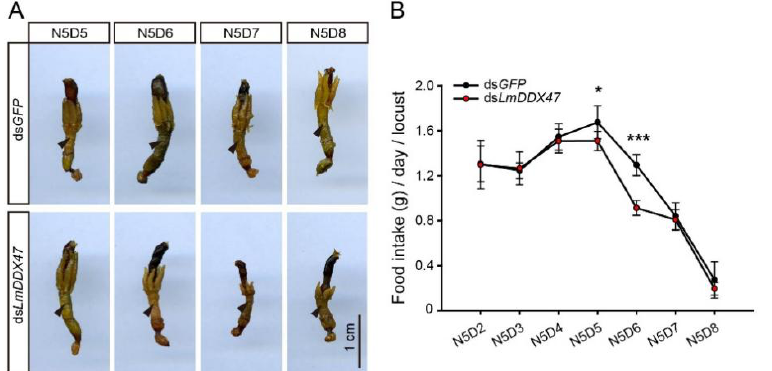
Figure 4. Dynamic changes in intestinal morphology and food intake after LmDDX47 knockdown. ( A ) Dynamic changes in the intestinal development of L. migratoria after LmDDX47 RNAi. The black arrowhead shows the midgut. Scale bar = 1 cm. ( B ) Average daily food intake (g ± SD) per locust after LmDDX47 knockdown. * p < 0.05; *** p < 0.001.